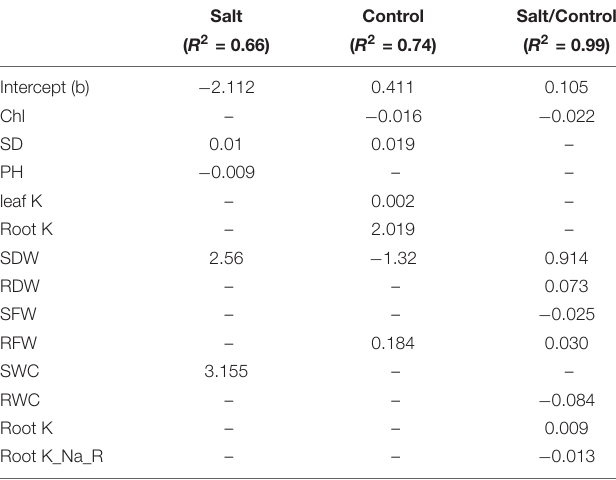
TABLE 3 | The correlations between the salt tolerance index (STI) and different agro-physiological traits (* p -value < 0.05, ** p -value < 0.01).